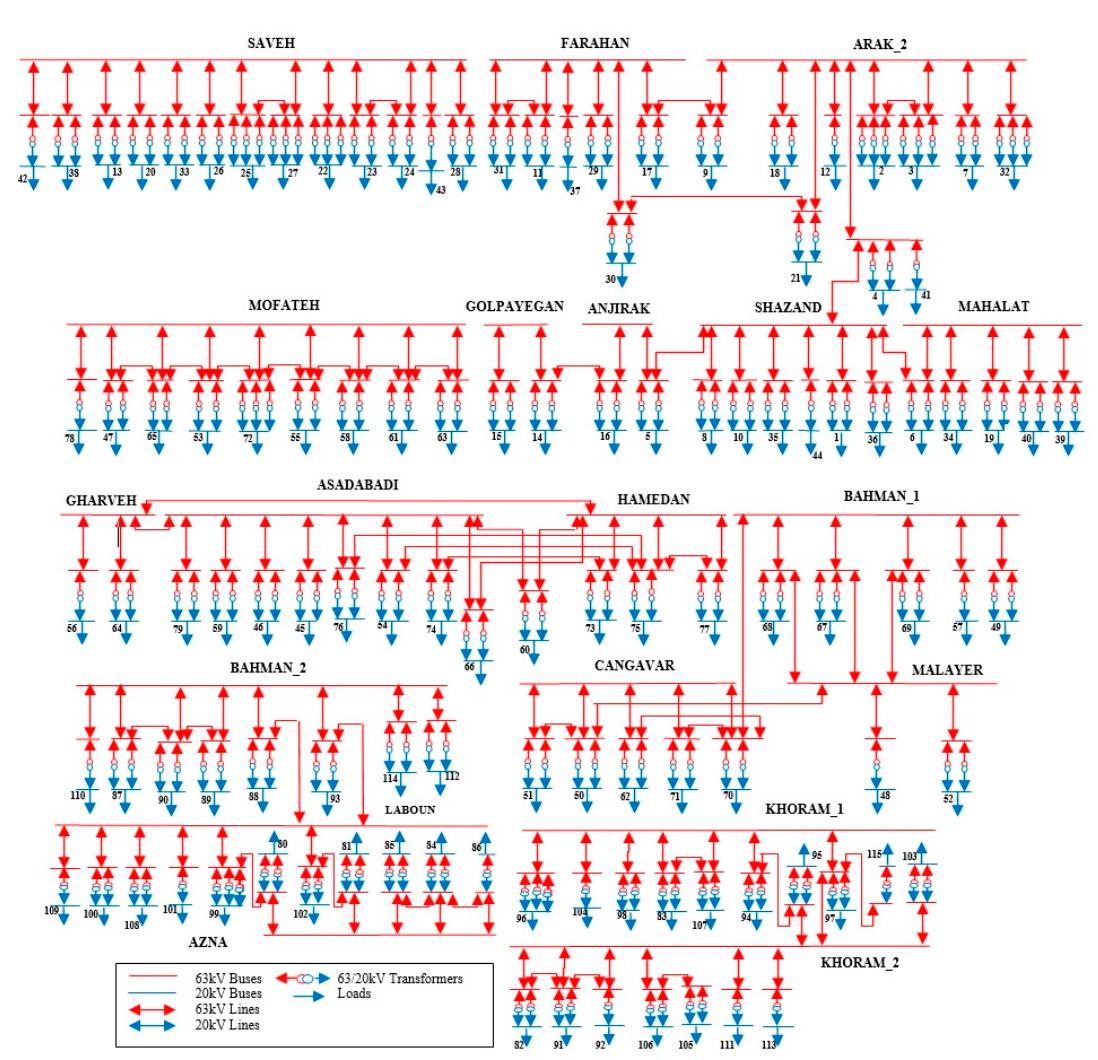
Figure 1. Single line diagram of the BREC network.